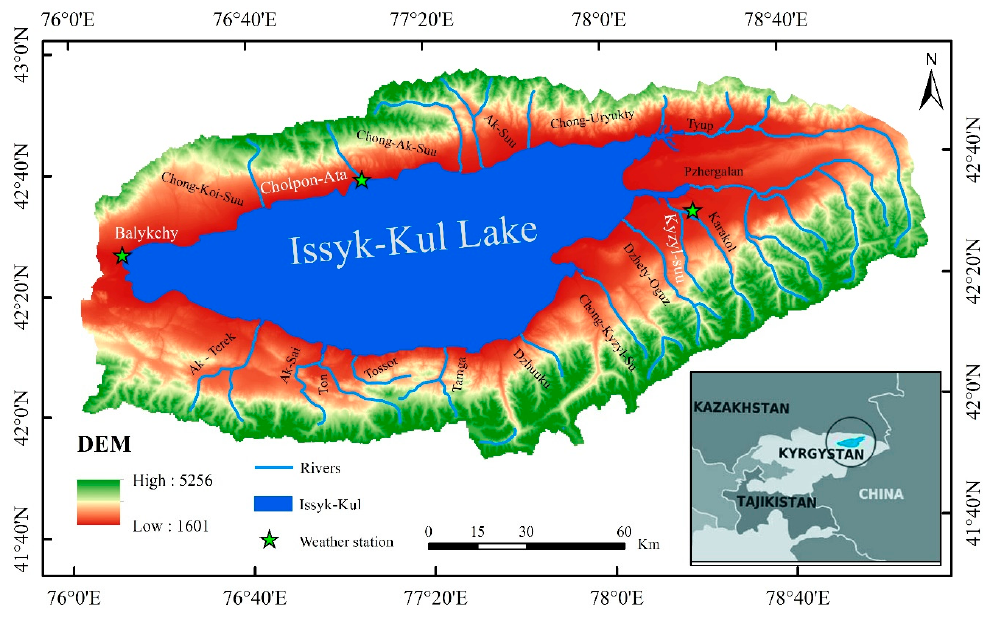
Figure 1. Lake Issyk-Kul Basin Map. Table 1. Descriptive statistics of annual and seasonal river runoff (m 3 /s) at study hydrological stations between 1943 and 2012.